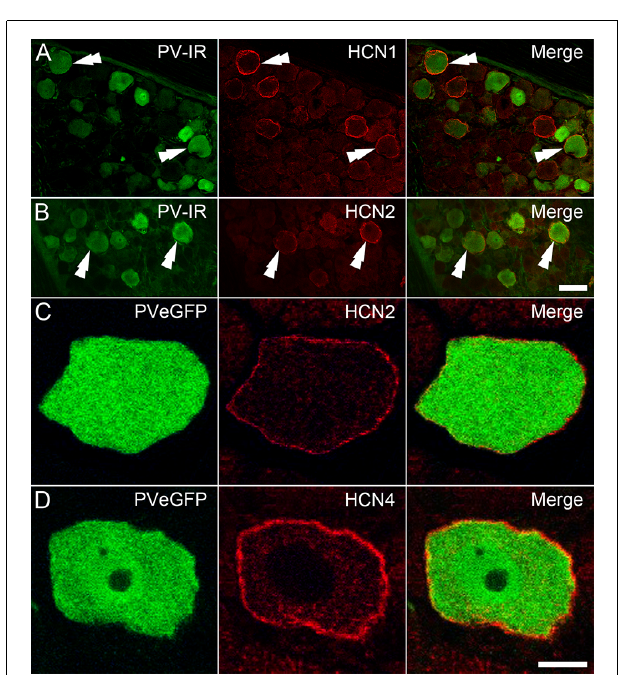
FIGURE 6 | Immunohistochemical localization of HCN subunits in PV-expressing DRG neurons. (A,B) PV-IR DRG neurons (green) in wild-type mice were shown to express both HCN1 ( A ; red) and HCN2 ( B ; red), with examples denoted by double arrowheads. (C,D) In DRGs from PVeGFP mice, GFP-expressing cells (green) showed immunolabeling for both HCN2 ( C ; red) and HCN4 ( D ; red). Immunolabeling for each of the HCN subunits was restricted to the cell membrane. Scale Bars ( µ m): (A,B) = 50; (C,D) =